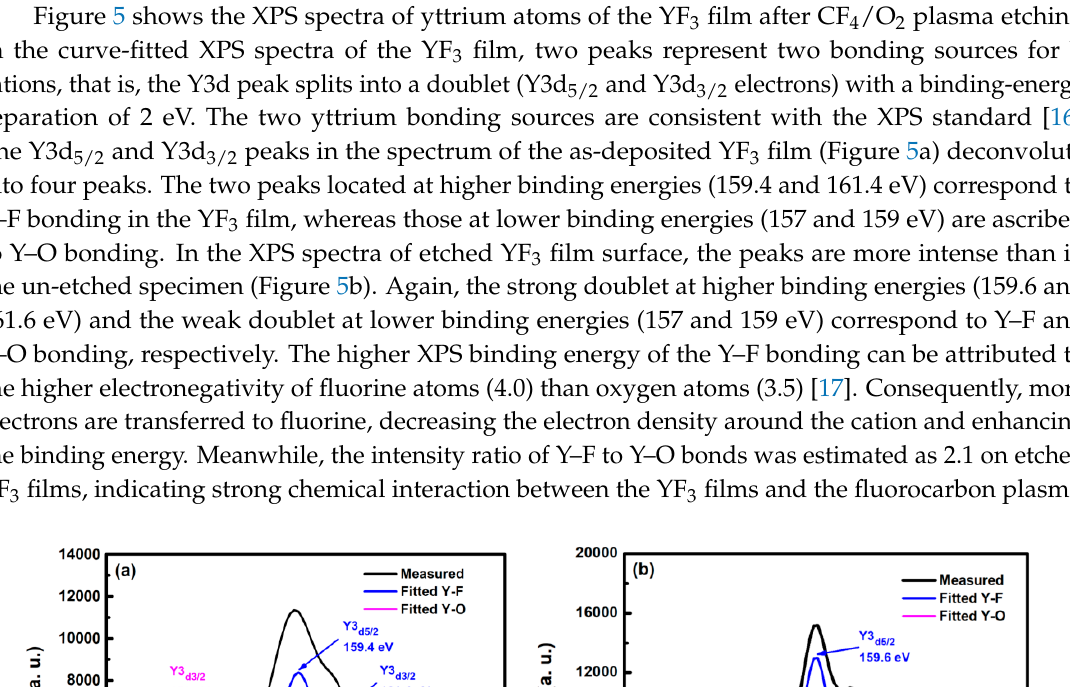
Figure 6. Etching depths of the YF 3 film and Al 2 O 3 substrates after different CF 4 /O 2 plasma exposure times.